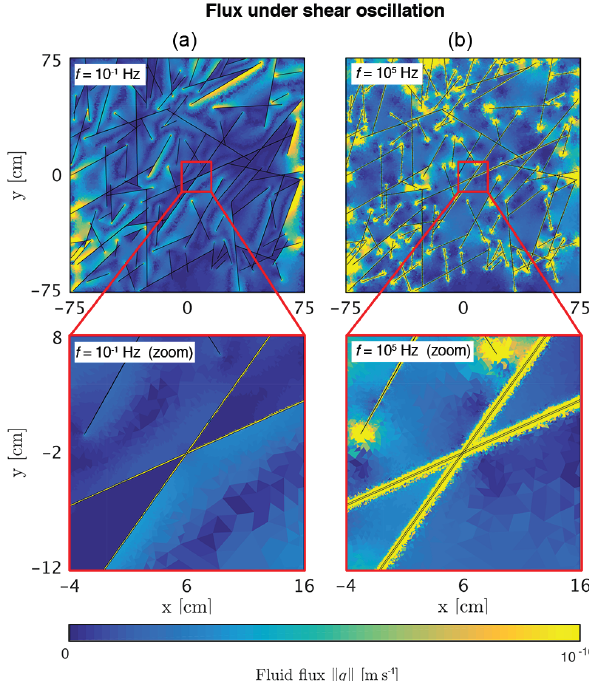
Figure 13. Amplitudes of pore fluid fluxes occurring under oscilla- tory shear at 10 − 1 Hz (a) and 10 5 Hz (b) , for the fractured rock properties corresponding to lithology B at a lithostatic stress of 15MPa (seismic properties for the same case are shown in Fig. 11b and d). Subplots at the bottom are enlarged views of specific regions in the top plots, marked with the red